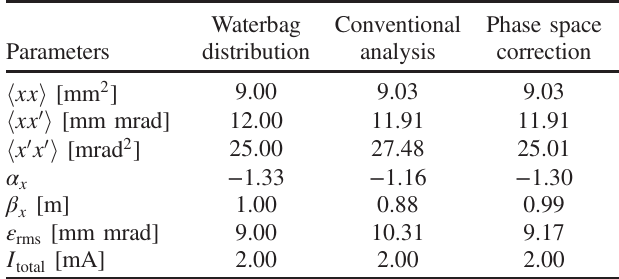
TABLE IV. Beam parameters of the two distribution in Fig. 9 compared against those of the waterbag distribution.